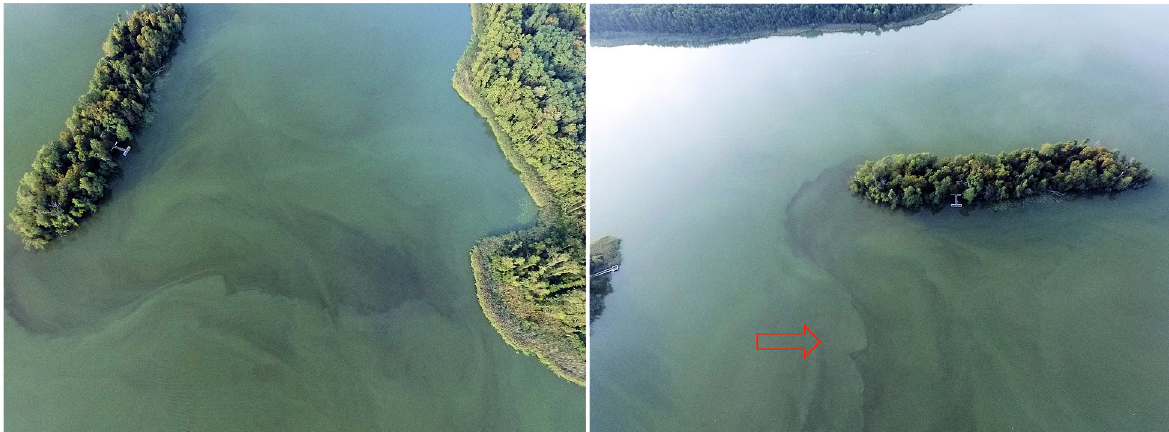
Fig. 9. Monitoring of pollution movement on the example of blooms in Lake